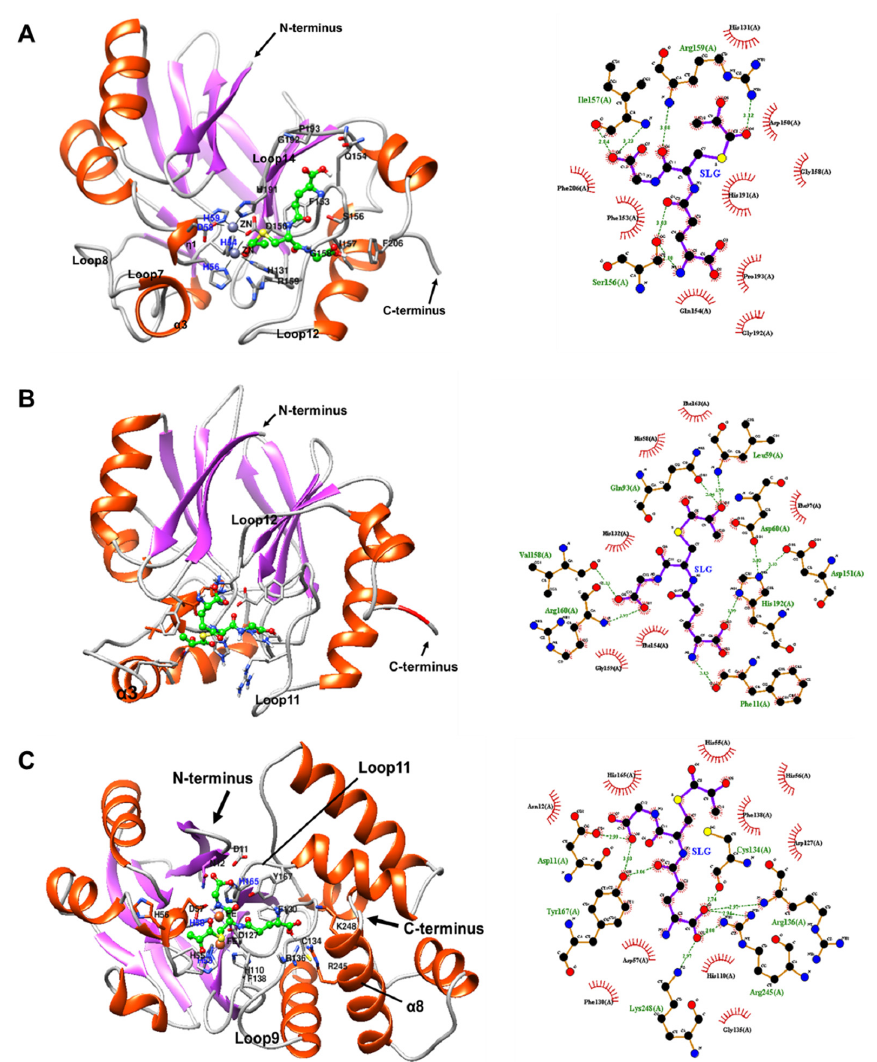
Figure 11. 3D complex structure ( left ) and 2D interaction diagram ( right ) of ( A ) BLEG-1-SLG, ( B ) YcbL-SLG, and ( C ) GloB-SLG. In 3D complex structure, SLG molecule is colored in green. In the 2D interaction diagram, red spoked arc represents hydrophobic interaction or non-bonded contact, green dash indicates hydrogen bond, and purple solid line represents ligand bond.